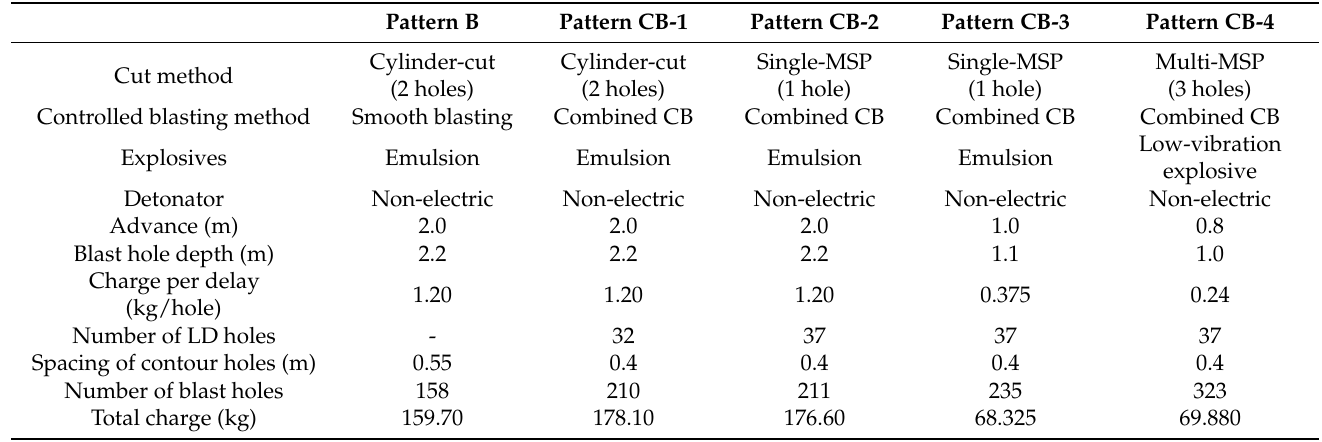
Table 3. Patterns of real-scale test blasting (base case (B), controlled blasting